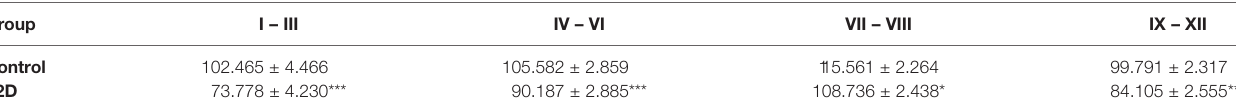
TABLE 3 | The seminiferous epithelium thickness ( m m) for different stages of sperm production. Group